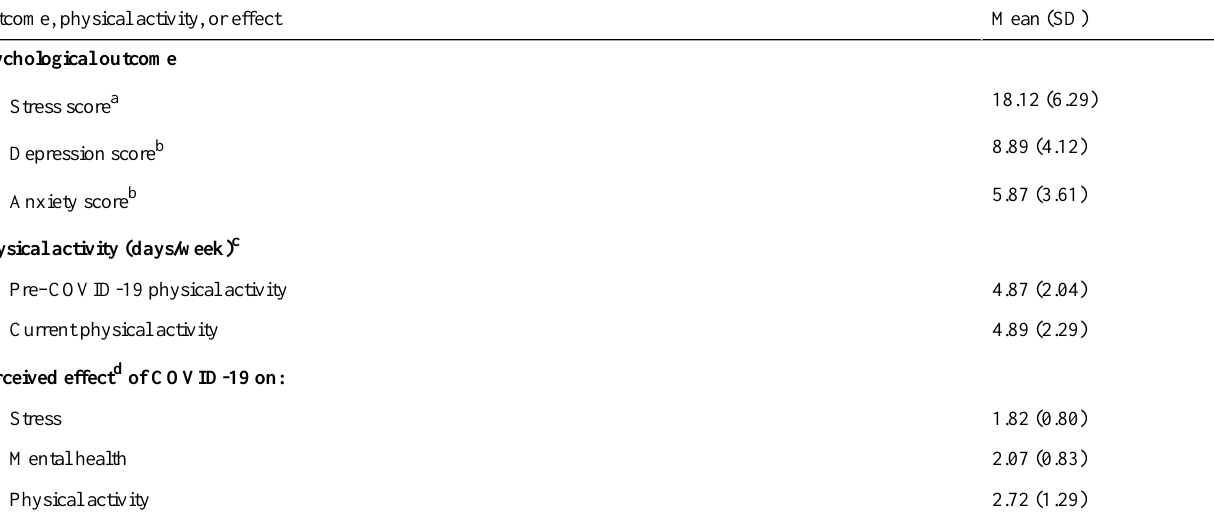
Mean (SD)Outcome, physical activity, or effect